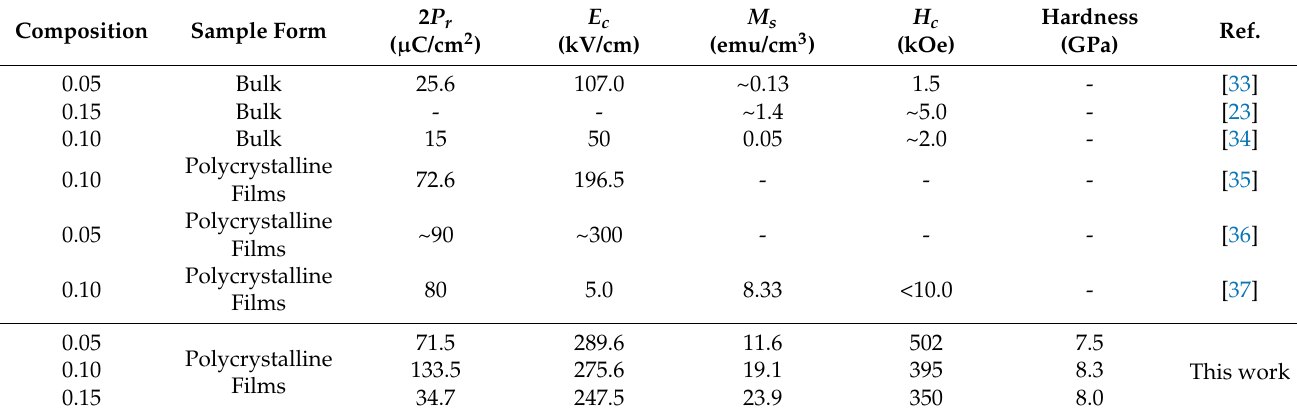
Table 1. Comparison of the developed Gd-doped BFO bulks and films: the multiferroic and nanomechanical characteristics. Composition Sample